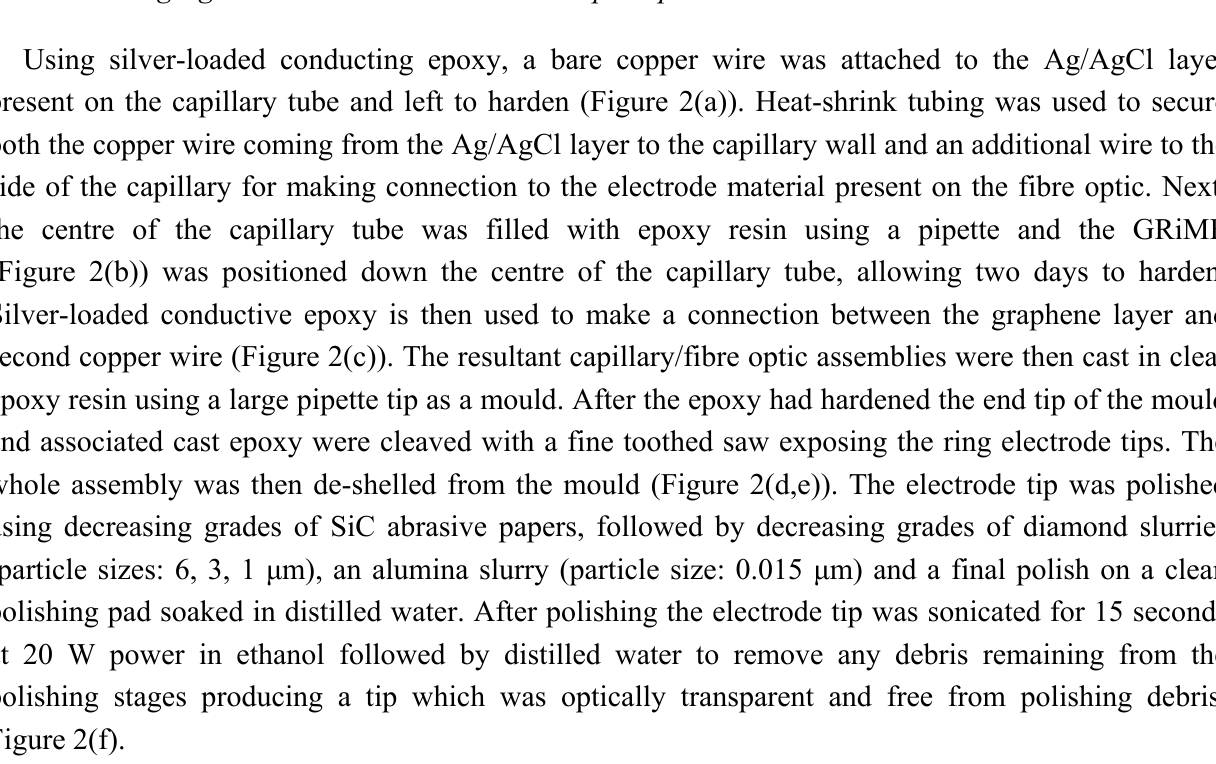
Figure 2. Stages of fabrication of the GRiME and concentric Ag/AgCl reference